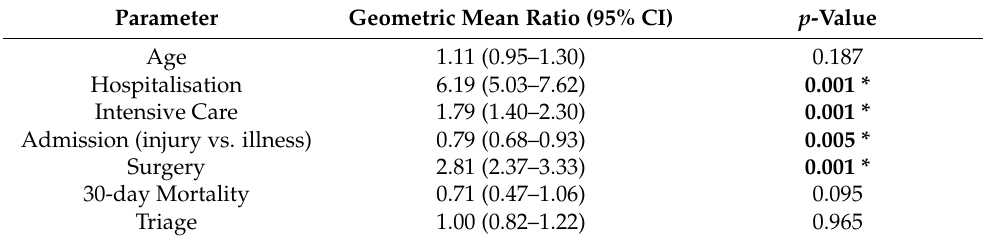
Table 5. Multivariable regression model of the association between total hospital costs with different parameters. Results of log transformed linear regression, expressed as geometric mean